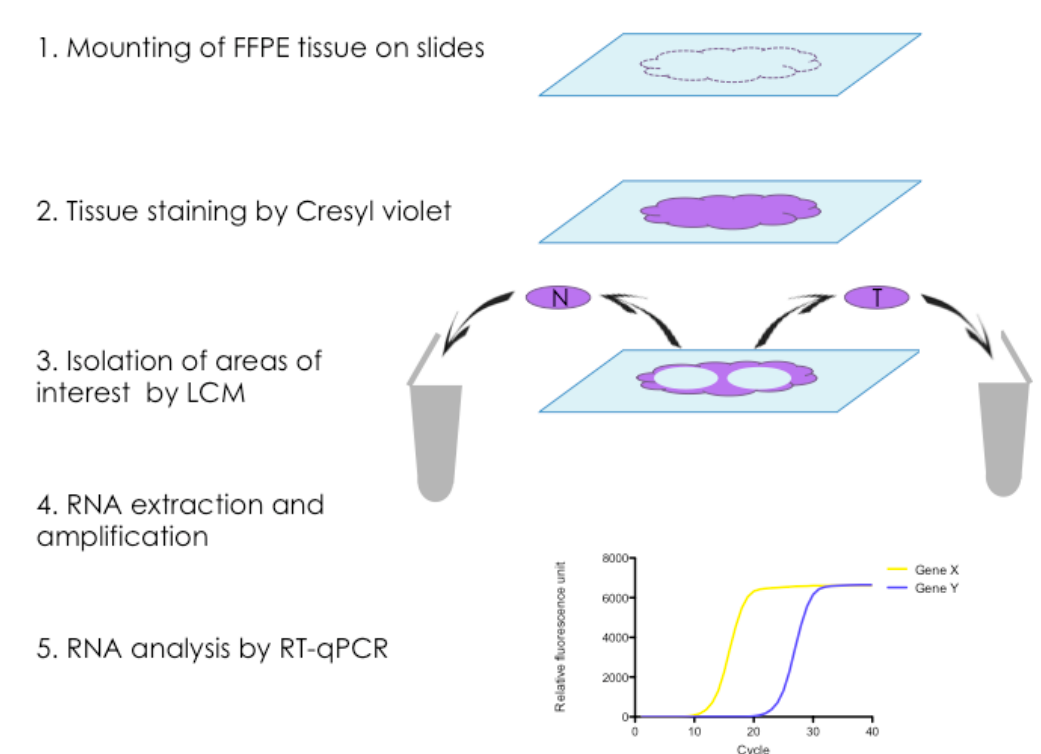
Figure 1. Protocol for isolation and analysis of matched normal and cancer-associated stroma from FFPE tissue sections. (1) Formalin-fixed paraffin-embedded (FFPE) tissue sections are cut and mounted onto PEN (Polyethylene naphthalate) Membrane Glass Slides (Applied Biosystems™); ( 2 ) Tissue is stained with Cresyl violet to facilitate visualisation of areas of interest under the microscope; ( 3 ) Areas of normal stroma (N) and tumour stroma (T) are isolated from the same slide under the microscope using Laser-Capture Microdissection, and harvested into separate tubes; ( 4 ) RNA extraction, quality control, quantitation, and preamplification; ( 5 ) Relative mRNA levels of selected genes are analysed by RT-qPCR.